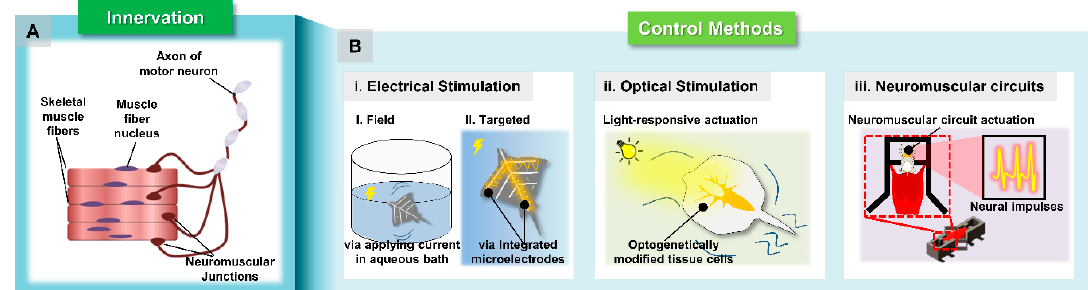
Figure 4. ( A ) Schematic illustration of muscle innervation. ( B ) Various control methods of centimeter- scale biohybrid soft robots ( B , i ) electrical stimulation, ( B , ii ) optical stimulation and ( B , iii ) neuromuscular co-culture. [43] © Copyright 2019, Elsevier